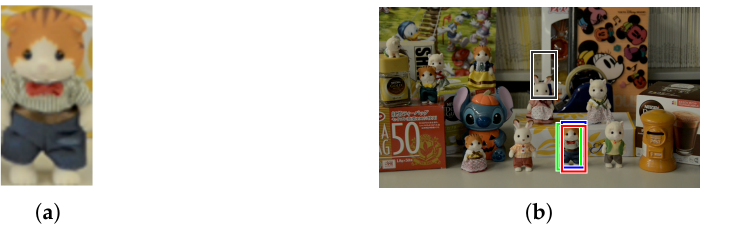
Figure 11. Search in a cluttered scene. The red, blue, green, and black bounding boxes represent the matching results of ABC, CI, CCH, and TFCM, respectively. ( a ) Reference. ( b ) Cluttered scene under dark illumination.